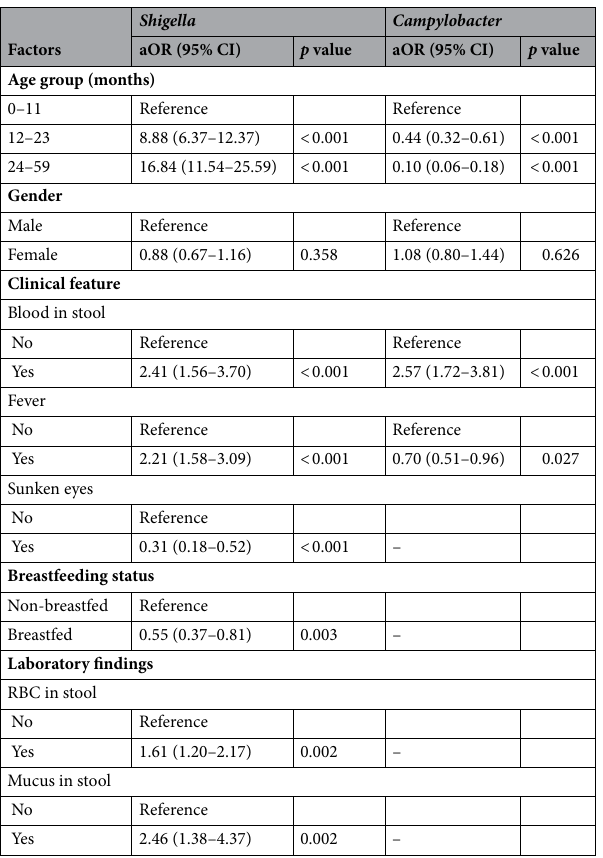
Table 2. Results of multiple logistic regression after exploring the associated factors of Shigella and Campylobacter infections in MSD children aged less than 5 years in Bangladesh. Fever: measured at least 38 °C or parental perception, RBC, red blood cell; aOR, adjusted odds ratio; CI, confidence interval.